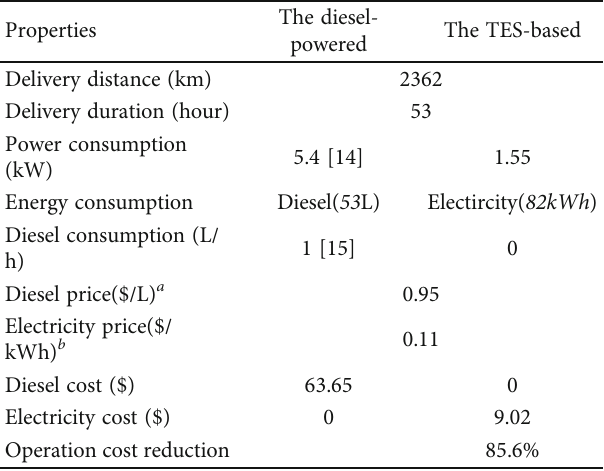
Table 2: Comparison of the energy and economic performance of the TES and diesel-powered